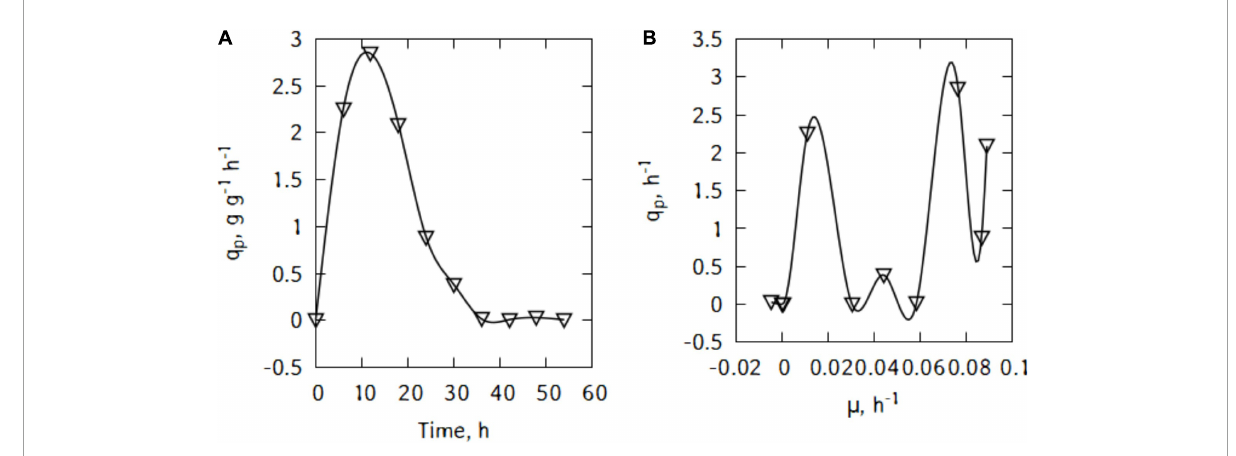
FIGURE3 LBA productivity (A) and correlation between productivity and growth (B) of P. taetrolens in traditional cheese whey.